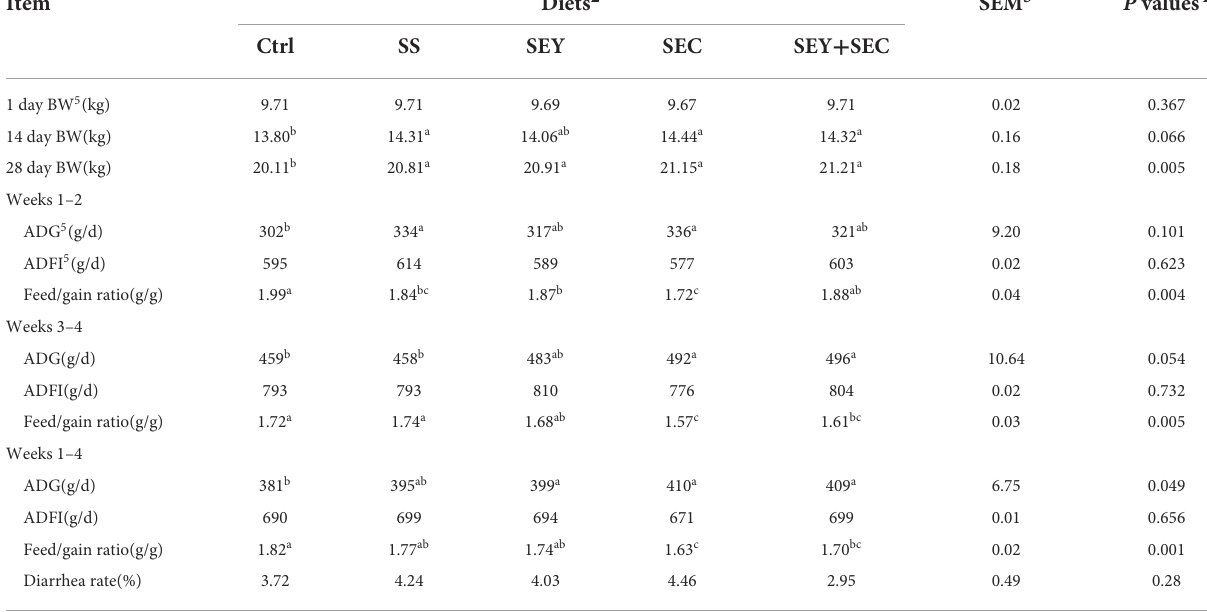
TABLE 2 Effects of different Se sources on growth performance of weaned piglets 1 . Item Diets 2 SEM 3 P values